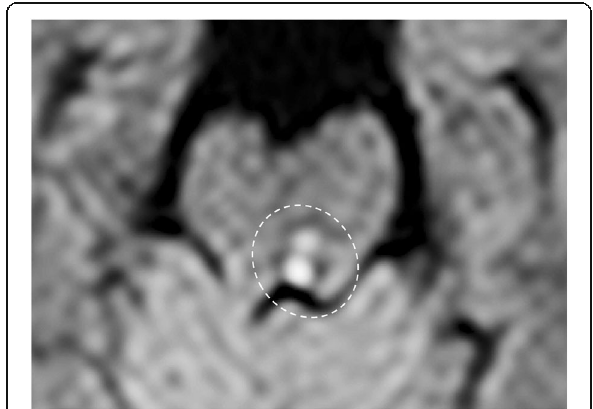
Fig. 32 Trochlear nucleus ischemia. Patient with diplopia. MRI DWI (b1000) image shows restriction of the diffusion in the left posterior midbrain, in correspondence of the trochlear nucleus, suggestive for recent ischemic lesion (dotted